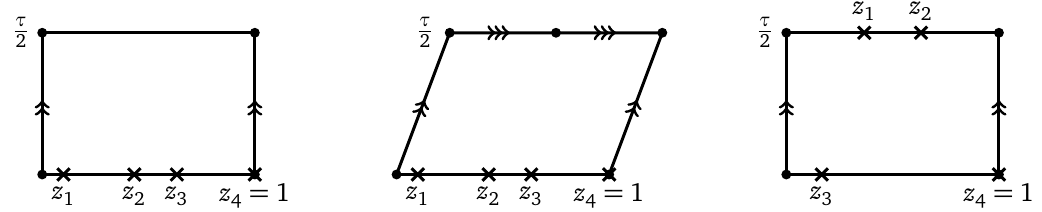
Figure 7: The geometries of the three open string one-loop amplitudes. The first picture is the planar annulus, the second the Möbius strip and the third the non-planar annulus. They are all obtained by orientifolding a torus under the action z → ¯ z . In the annulus cases the modular parameter is purely imaginary, whereas τ ∈ 1 the case of the Möbius